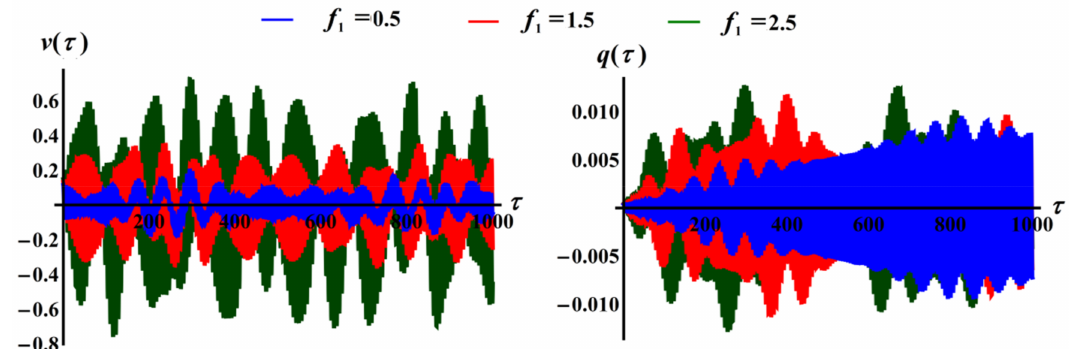
Figure 32. The time histories of the output voltage due to the existence of the piezoelectric device and the current from the electromagnetic device with different chosen values of excitation amplitudes.